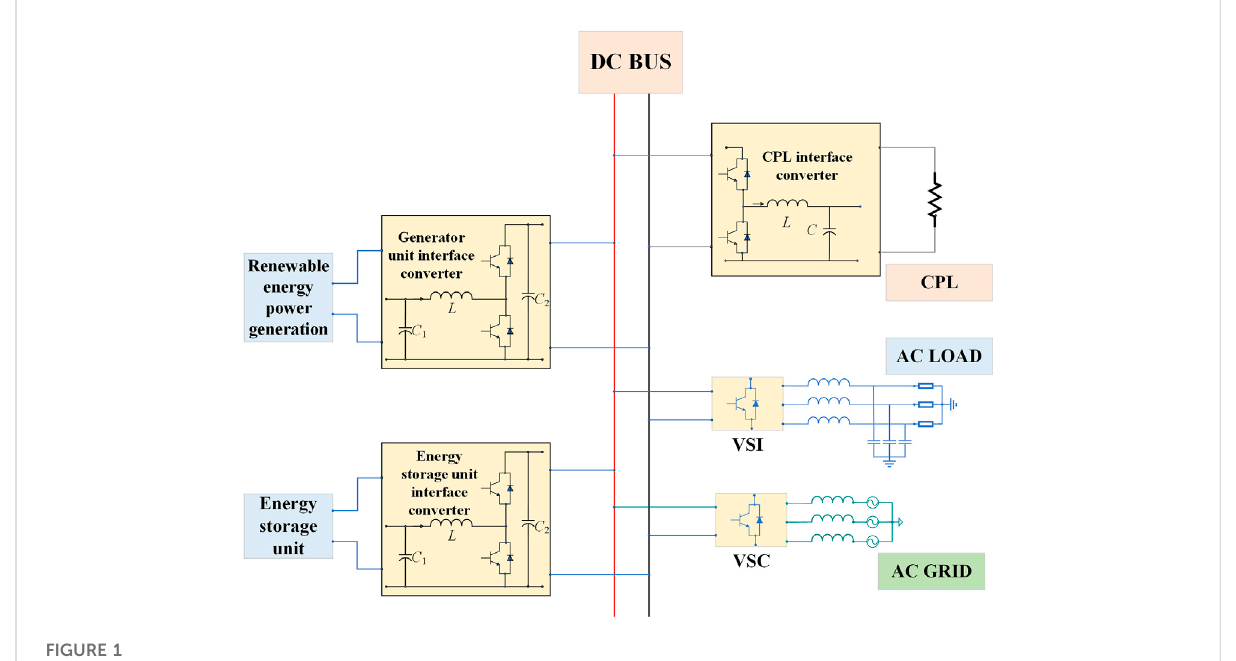
FIGURE 1 Structure diagram of DC microgrid with